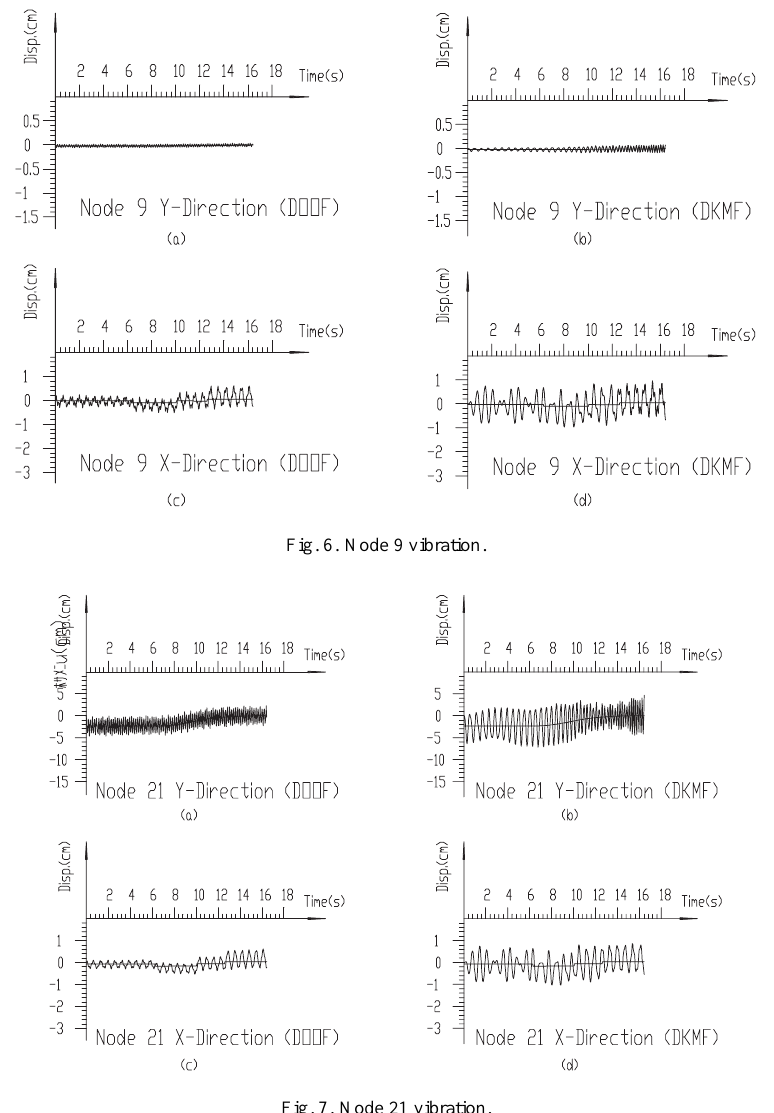
Fig. 6. Node 9 vibration.